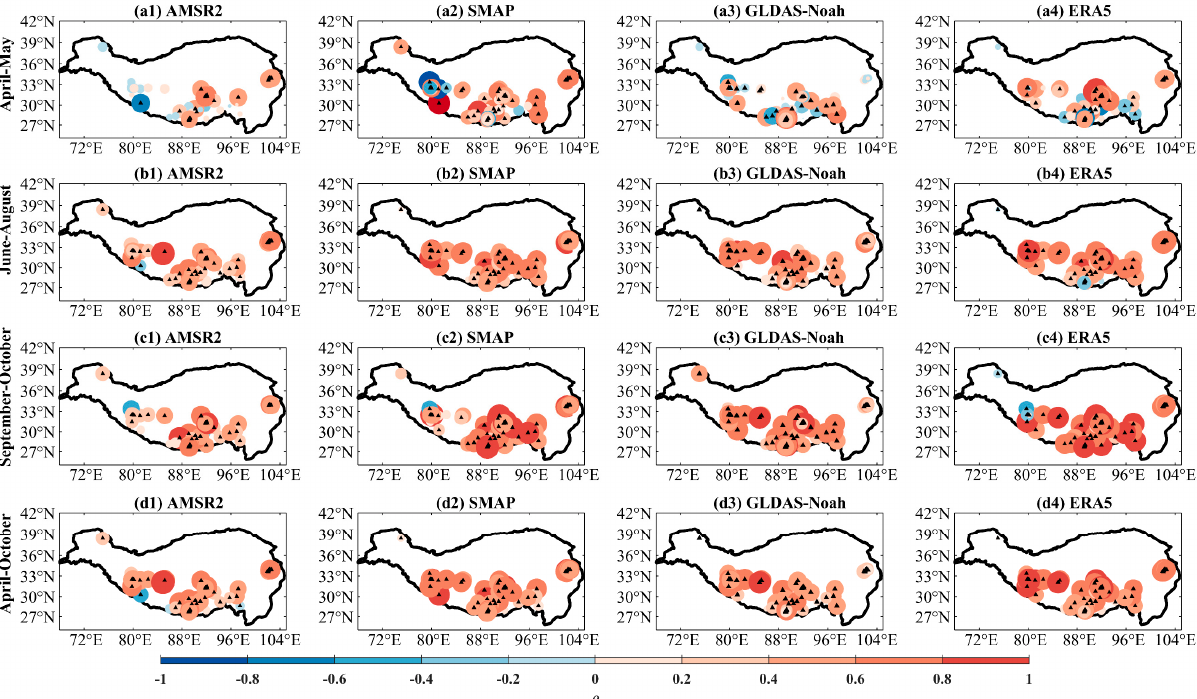
Figure 7. Spatial distributions of 𝜌 for daily AMSR2, SMAP, GLDAS-Noah, and ERA5 SM in different seasons during the non-frozen period from 2015 to 2016 in the TP. The black triangles represent statistically significant at 95% confidence level. The size of the circles represents the absolute value of 𝜌 at each measurement station.